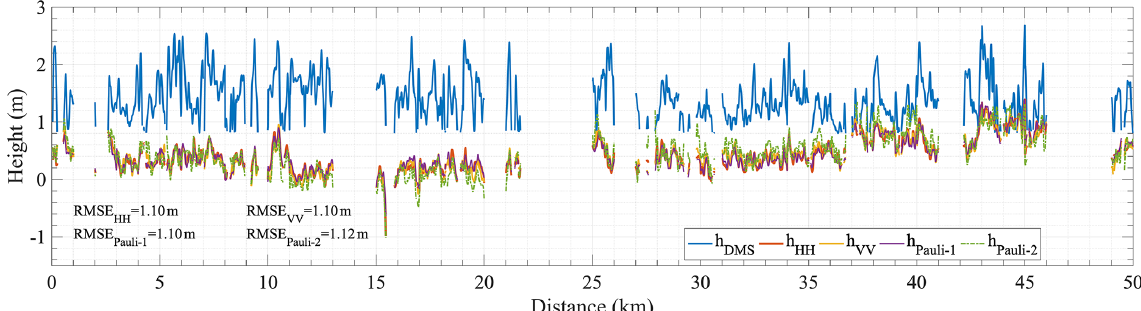
Figure 5. The InSAR-derived height profiles ( h InSAR ) and the DMS DEM ( h DMS ). Each profile represents the height along a 1 × 5000-pixel section at the center of the coregistered segment. The mis-coregistered and h DMS -below-0.8m samples are excluded from the plots.